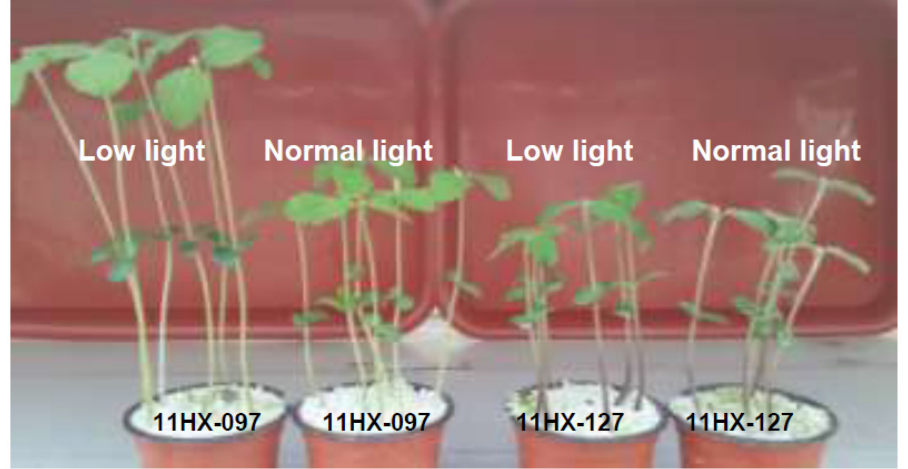
Figure 1. Performance of low-light-sensitive and low-light-resistant soybean accessions in low-light conditions. Accession 11HX-097 is a low-light-sensitive material, and the plant height increased significantly under low-light. Accession 11HX-127 is a low-light-resistant material, and plant height did not change significantly under low-light. Table 1. Variation of 185 representative accession materials for traits related to stalk development under normal and low-light